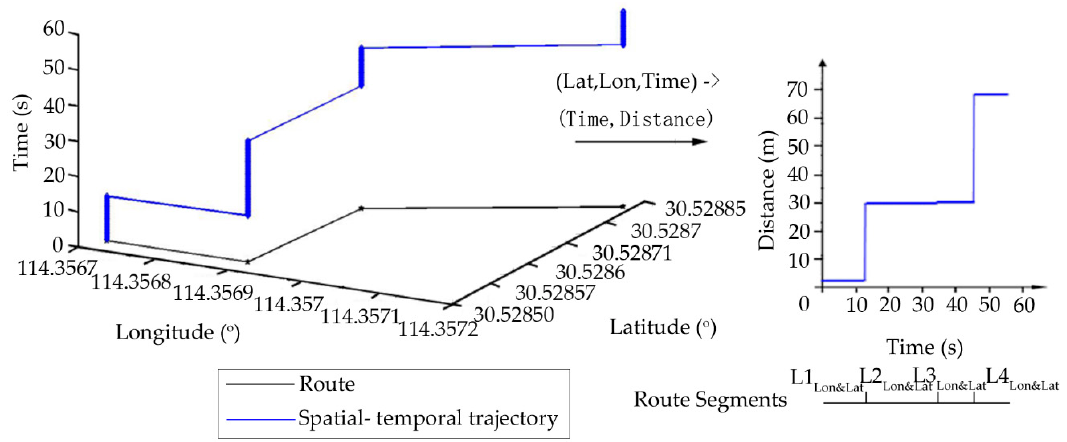
Figure 6. Data of Global Positioning System.